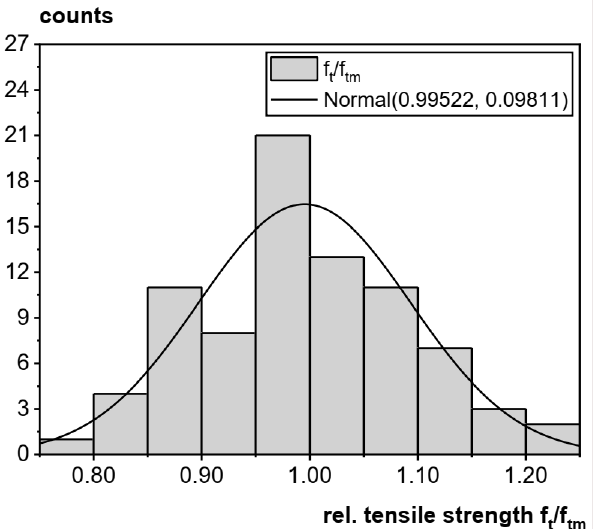
Figure 4. Histogram of the relative tensile strength (ref.: maturity function) and associated Gauss distribution for samples after storage in saturated Ca(OH) 2 solution (series with CEM I 42.5 N, CEM I 42.5 N-SR3 and CEM I 42.5 N +